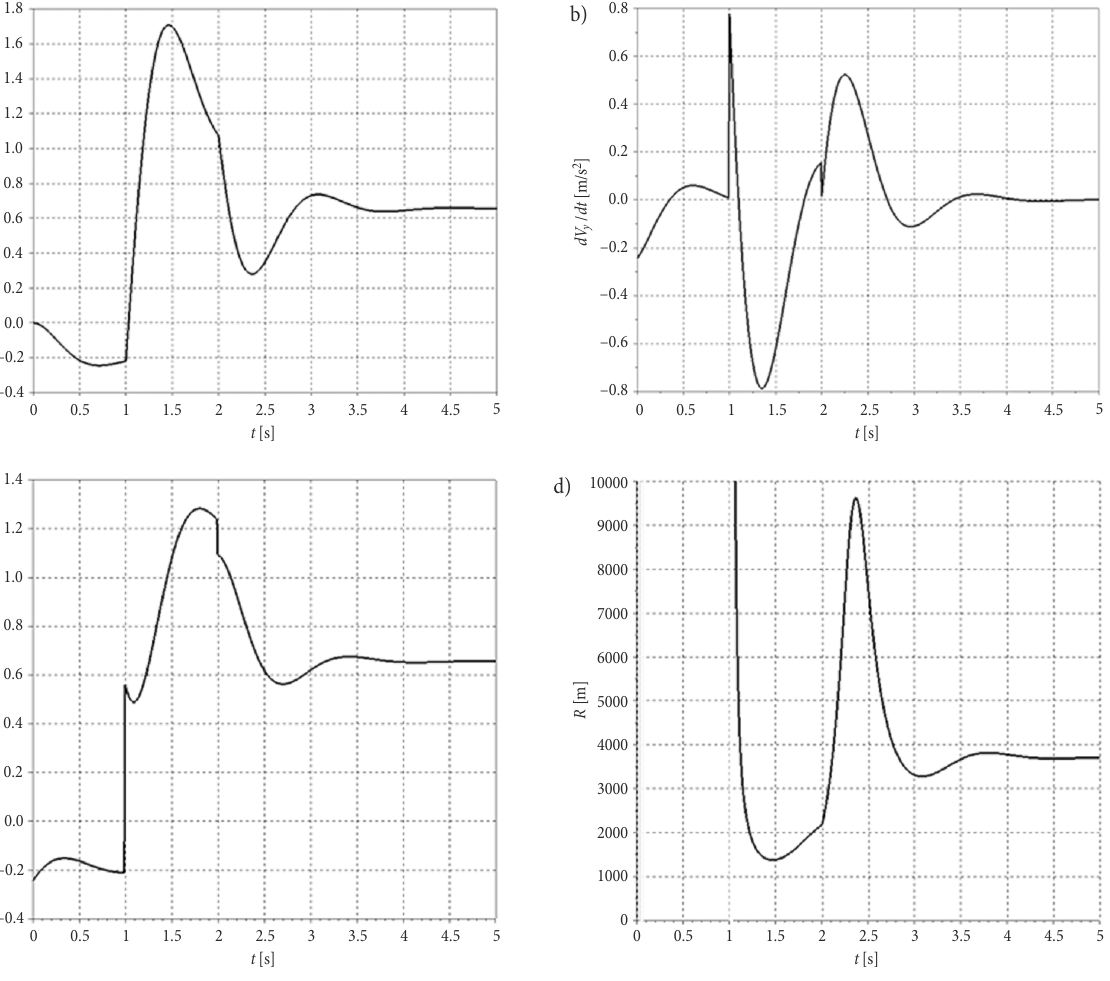
Fig. 5. Transient bicycle model results for scenario 1: a – lateral acceleration due to direction change of V x ; b – lateral acceleration cause by tiredeformation; c – total lateral acceleration; d – path radius against time